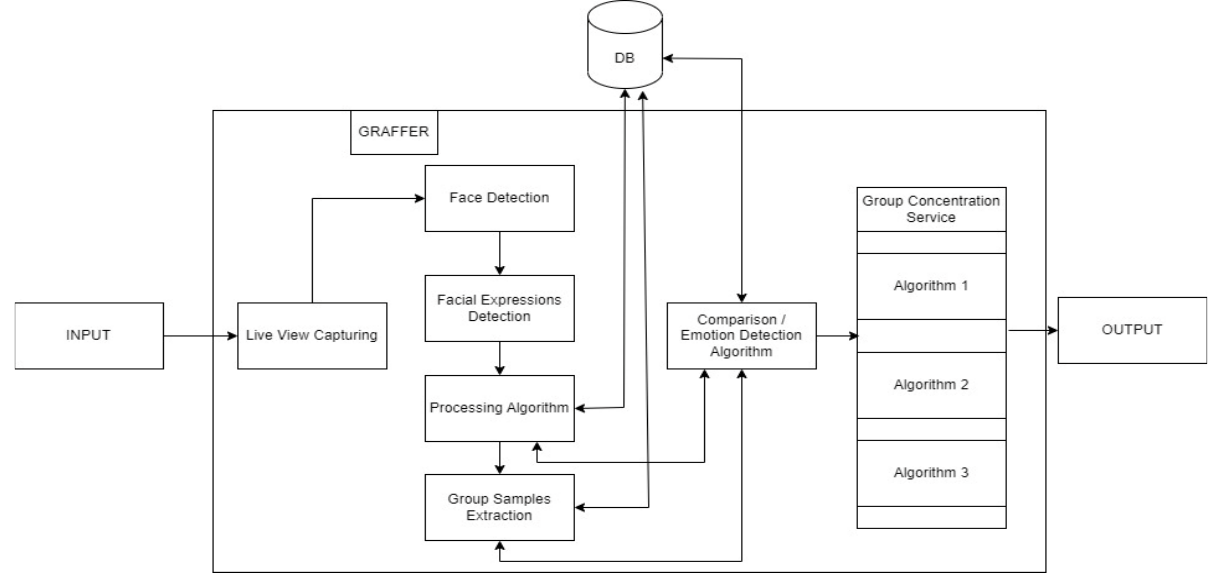
Figure 2. System architecture.